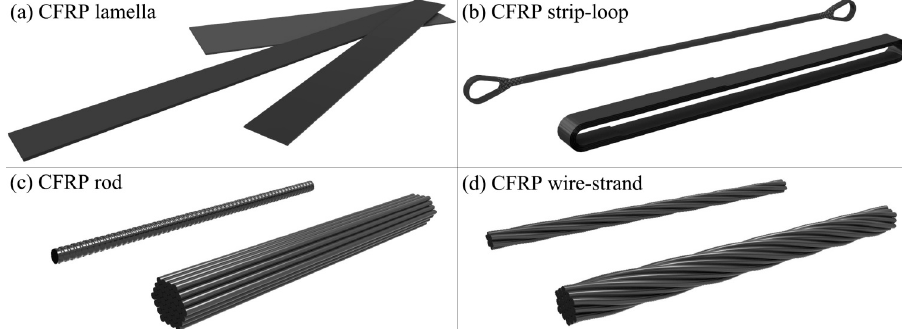
Figure 5. Four main types of CFRP cables: ( a ) the CFRP cable in the form of lamella, which can be fabricated by pultrusion or lamination; ( b ) the CFRP cable in the form of rod, which is usually fabricated by pultrusion; such CFRP cable can be made up of a single rod or a rod bundle, and the CFRP rod can be plain round or deformed; ( c ) the CFRP cable in the form of strip-loop, which is fabricated by winding a continuous CFRP strip on two pins; then the strip-loop can choose to be laminated or non-laminated; and ( d ) the CFRP cable in the form of wire-strand which is fabricated by twisting several CFRP wires into a helix. The CFRP wires used are usually produced by pullwinding.